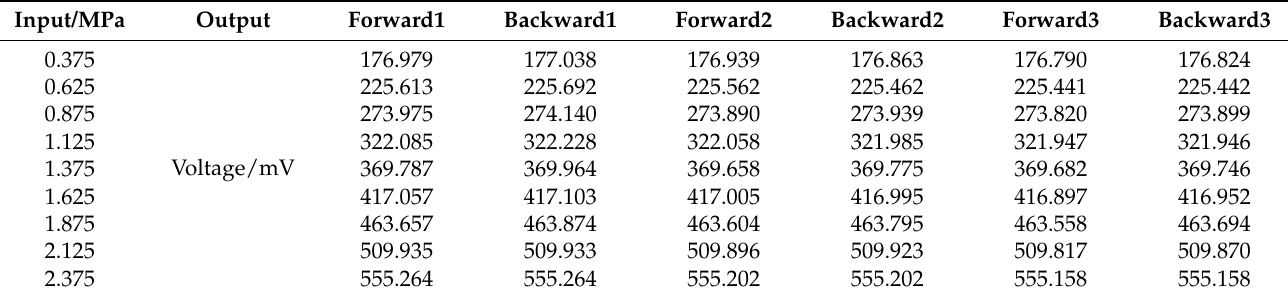
Table 2. Comparison of sensor performance.